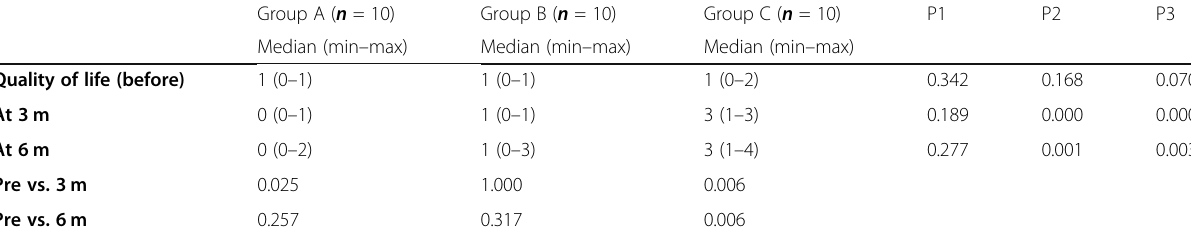
Table 1 Quality of life score before therapy and 3 and 6 months after therap y[8]